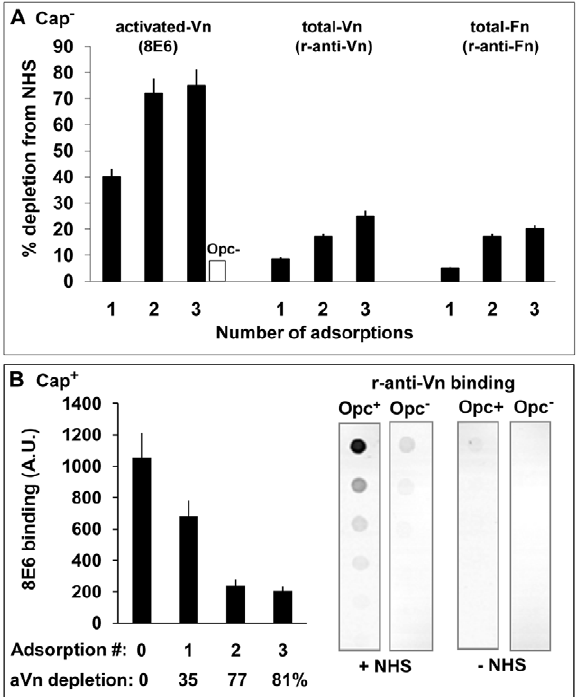
Figure 2. Activated vitronectin is adsorbed preferentially from serum by capsulate and acapsulate Opc-expressing N.meningi- tidis . (A) To assess which serum protein is preferentially removed from serum by Opc + Nm, a sample of normal human serum was adsorbed three times sequentially with Opc-expressing phenotype of acapsulate C751. At each stage, aliquots of the adsorbed serum samples were retained. Unadsorbed serum and adsorbed samples were analysed by immuno-dot blot assay (followed by densitometric analysis) for activated and total Vn/Fn levels using the mAb 8E6 and the polyclonal rabbit anti-Vn or anti-fibronectin antibodies. The levels of each of these components extracted from serum by Opc + Nm as a percent of the total present at the start of extraction are shown. In control experiments, in which Opc 2 Nm were used, 8E6 binding to 3 x adsorbed serum did not alter significantly and amounted to less than 10% loss of aVn (blank column). (B) In a similar experiment, a sample of NHS was adsorbed sequentially with capsulate MC58 Opc + and Opc 2 phenotypes. The